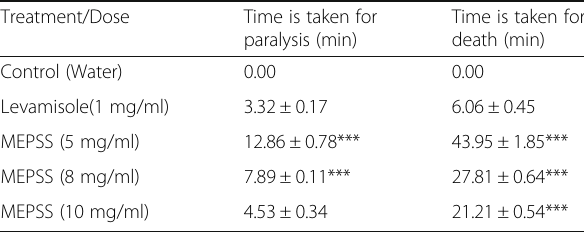
Table 3 Docking results of Levamisole (standard drug),